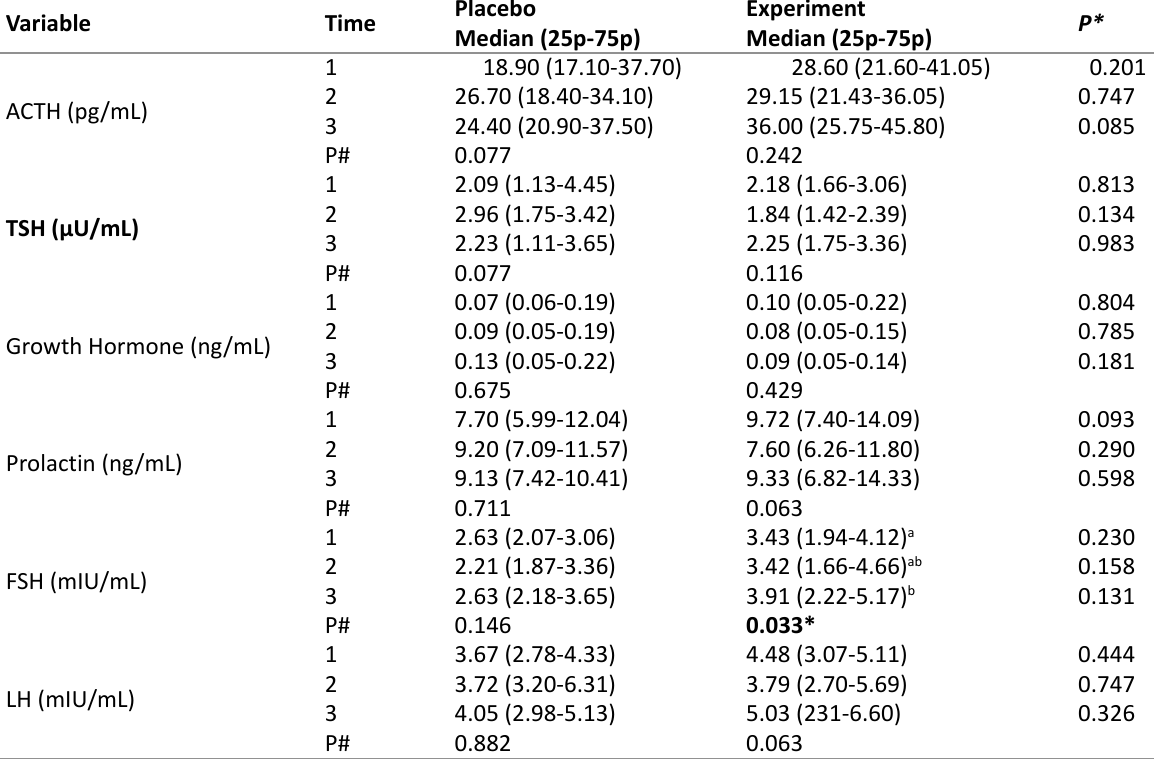
Table 4. Comparison of adenohypophyse hormone variables of the groups